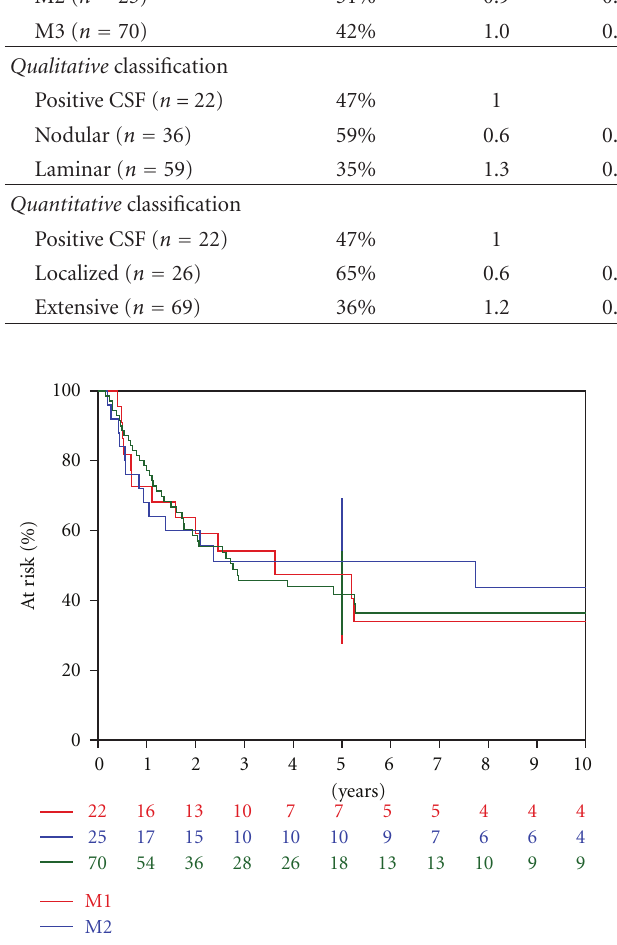
Figure 4: Overall survival according to Chang’s